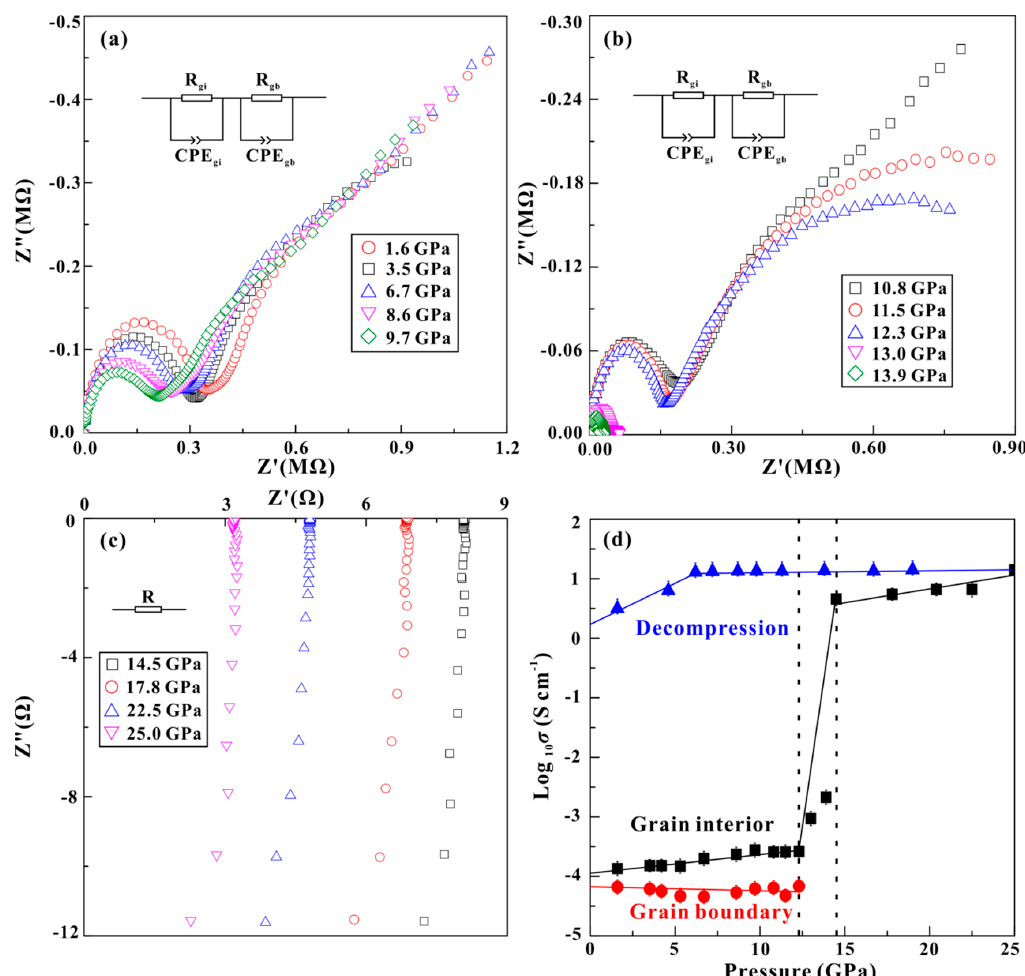
Figure 4. ( a – c ) Nyquist diagrams of the impedance spectra for nanocrystalline rutile at different pressures. R gi and R gb represent the resistance of the grain interior and boundary, respectively. CPE gi and CPE gb are the constant phase element of the grain interior and boundary, respectively. ( d ) The grain interior and boundary electrical conductivity of nanocrystalline rutile during compression and decompression process at atmospheric temperature.